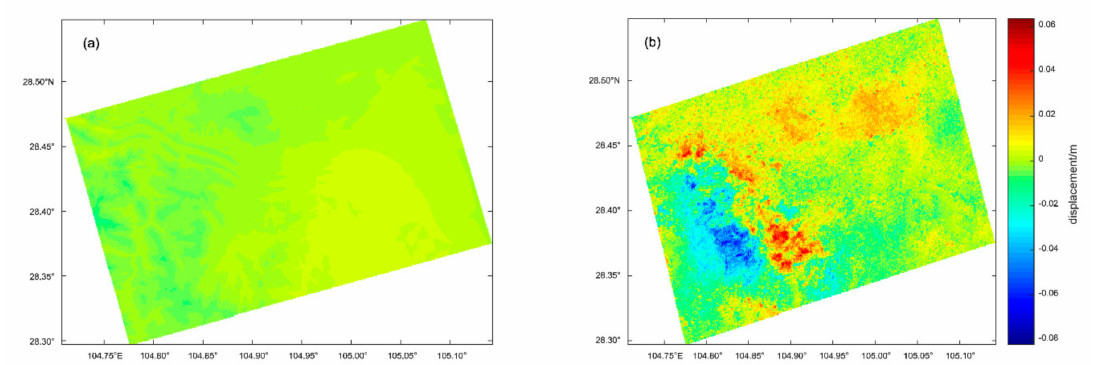
Figure 7. The corrected deformation displacement according to the GACOS model: ( a ) the multi- source data integrated atmospheric delay correction based on the GACOS model; ( b ) the corrected co − seismic deformation displacement according to the GACOS model. The color − coded strip represents the atmospheric delay correction model and the displacement in ( a , b ), respectively.